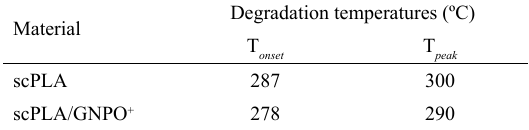
Table 1. Onset temperature (T temperature (T